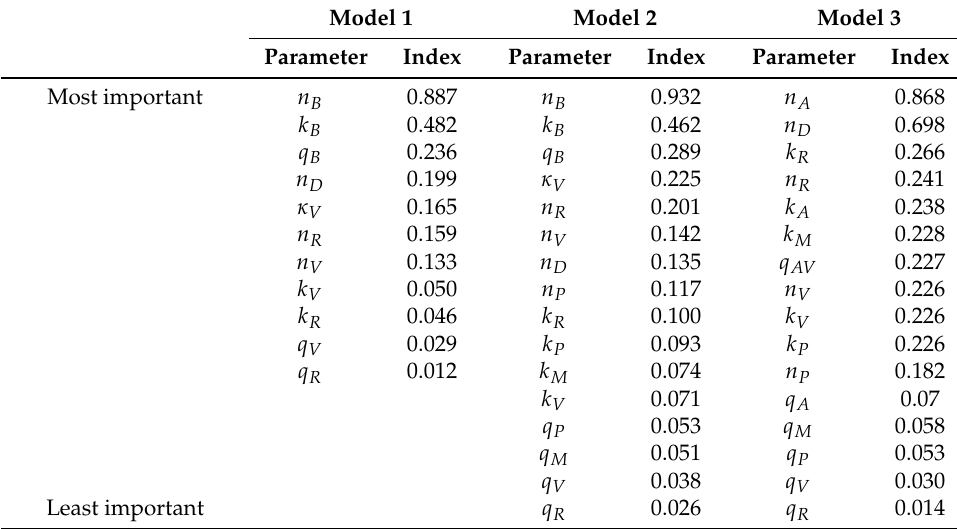
Table 3. Total order Sobol sensitivity indices for each proposed model. Parameters are listed from most important to least, according to sensitivity index [44]. 10 4 samples were generated with sensitivity to n B ∗ for model 1, n B ∗ for models 2 and n AD for model